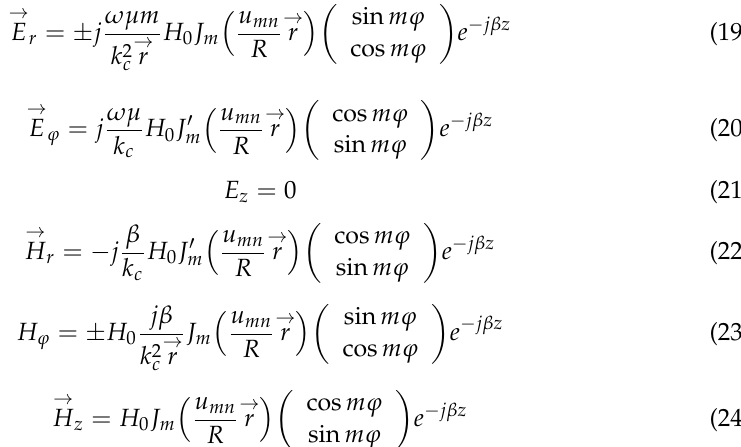
Figure 2. Three-dimensional model of cylinder defect. Figure 2. Three ‐ dimensional model of cylinder defect. When the defect is a cylindrical defect, the radius of the defect is R, the angle of the defect is φ , the depth of the defect is h , and the field distribution equation of the TE01-mode microwave at the defect is as